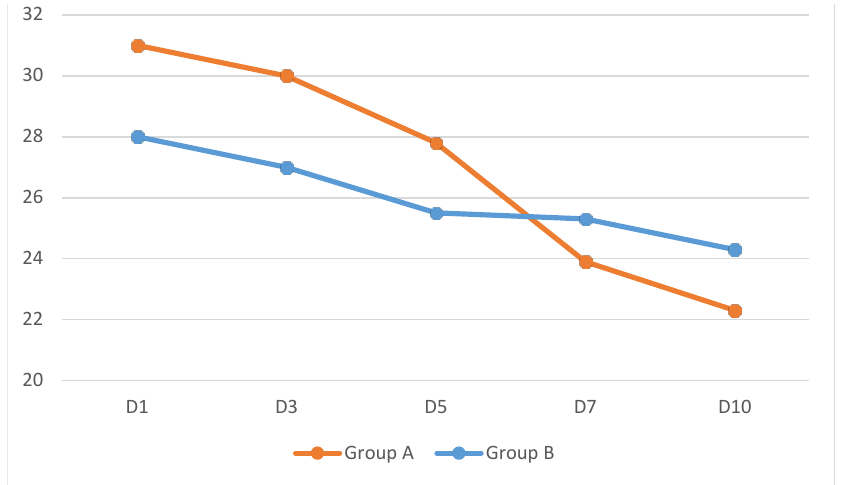
Figure 4. Evolution of mean levels in Group A (supplemented with the probiotic mix) and Group B (control group; standard treatment without probiotics) from enrolment (Day 1) to Day 3, 5, 7 and 10 days.